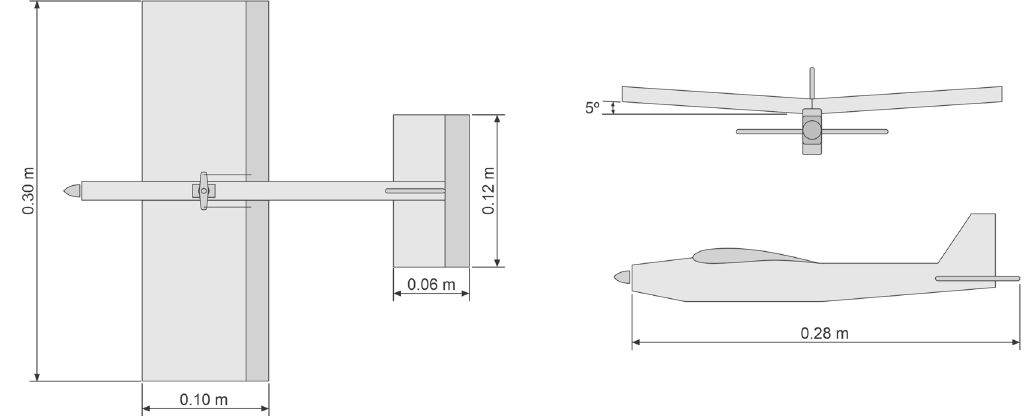
Figure 5. Prototype 4, made with extruded polystyrene.